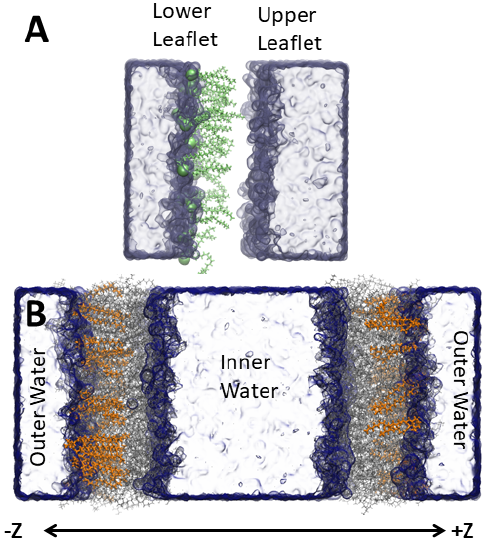
Figure 2. System setup illustrating the single ( A ) and double bilayers ( B ) with the amphiphilic molecules added to the ‘lower’ leaflet in the single bilayer and the ‘outer’ leaflet in the double bilayer. The added molecules are highlighted as green ( A ) and orange lines ( B ). The other lipids are grey lines, and water a blue surface.